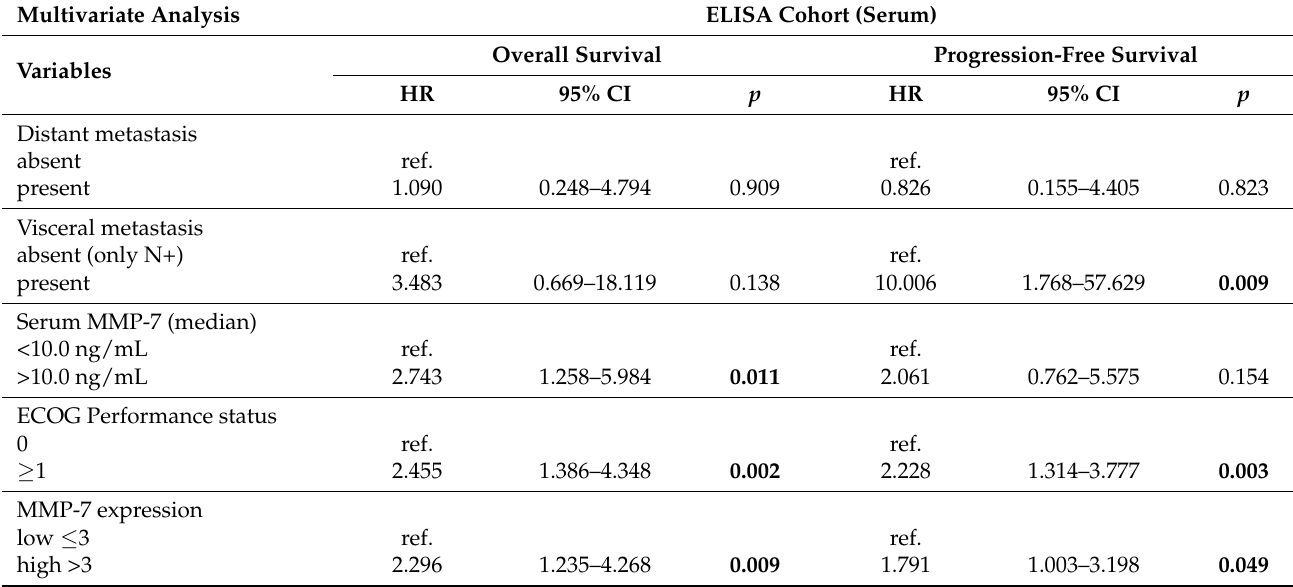
Table 4. Cox multivariate OS and PFS analysis in the ELISA and IHC